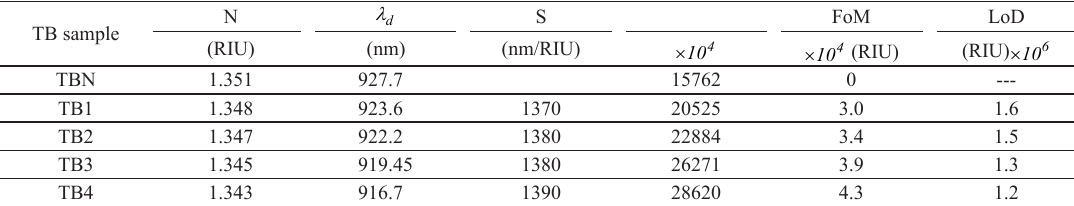
Figure 8. Transmittance spectra of defected PC with different blood samples of tuberculosis patients at N=7, 0 80 θ= and d Table 2. the performance parameters of the proposed